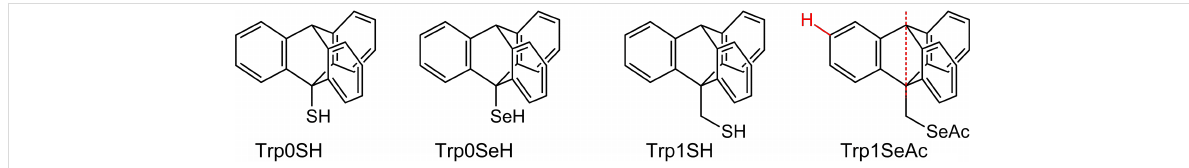
Figure 1: Schematic representation of the triptycene-based sulfur and selenium compounds used for the formation of SAMs on Au(111) surface. Exemplary, in the Trp1SeAc structure, the main molecular axis is shown as a dotted red line. In this structure, also the H atom bound to the C 3 atom is shown. This H atom has the highest distance to the chalcogen anchor group, which defines the maximum possible monolayer thickness. Both mo- lecular axis and theoretical maximum monolayer thickness are used in the